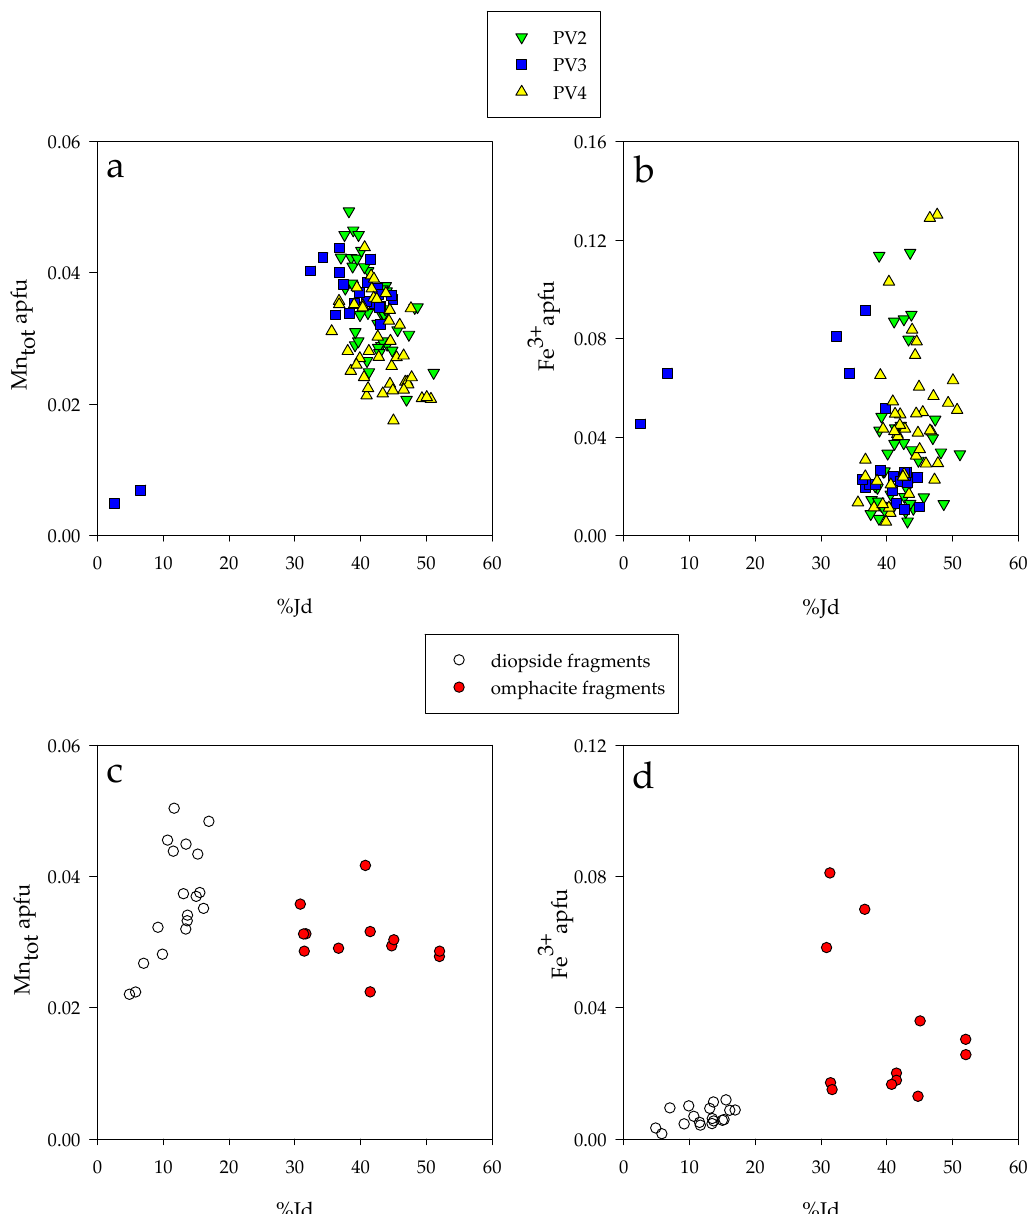
Figure 7. Variation of Mn tot and Fe 3+ versus Jadeite mol% (%Jd) in the studied samples. ( a ) Mn tot and ( b ) Fe 3+ in massive samples, ( c ) Mn tot and ( d ) Fe 3+ in fragments.